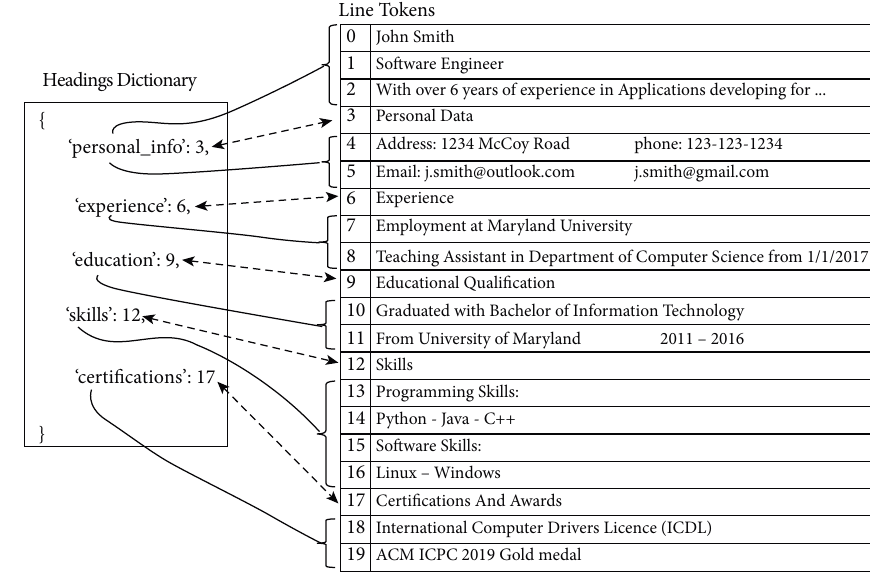
Figure 5: Illustration of extracting segment headings and their contents. Table 3: An illustrative example shows the output of each stage of the TSHD algorithm.